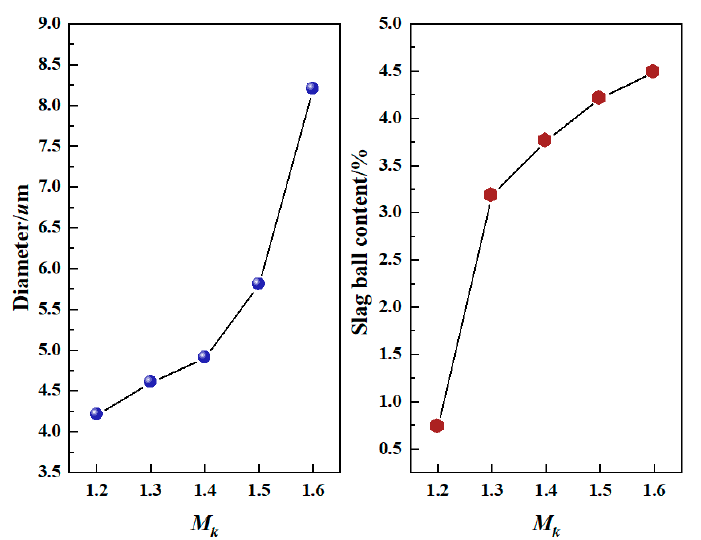
Figure 12. The average diameters and slag ball contents of the slag fibers prepared from modified blast furnace slags with different M k values.